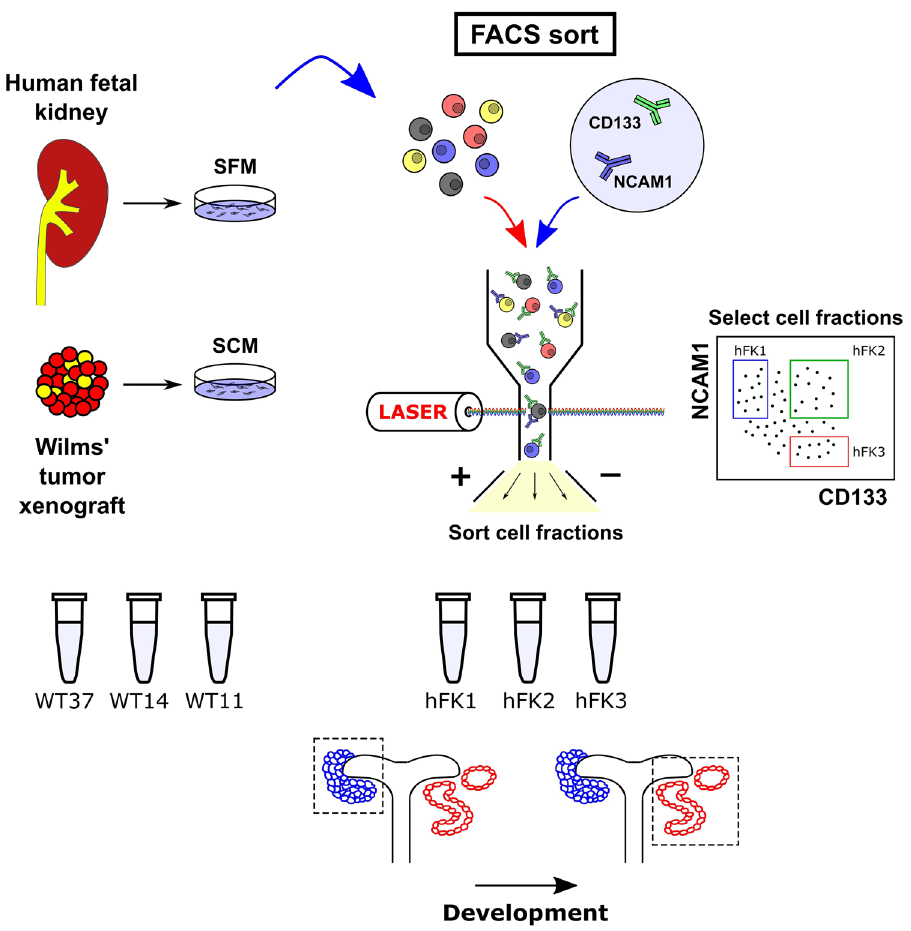
Figure 1. A sketch of the experiments performed to obtain the RNA samples that were analyzed in this study (see also Pode-Shakked et al. 7 ). Cells from a human fetal kidney (hFK) were cultured overnight in serum- free medium (SFM) which was found to help preserve a small population of undifferentiated cells. The cells were then dissociated and sorted by FACS to enrich for cell fractions representing three progressive renal developmental stages: NCAM-high/CD133-low (“hFK1”), a cell population that was previously found to be enriched for immature cells from early renal developmental stages, mainly the cap mesenchyme; NCAM- high/CD133-high (“hFK2”), an intermediate state, presumably enriched for cells representing early epithelial structures; and NCAM-low/CD133-high (“hFK3”), a population enriched for more differentiated epithelial cells. In parallel, cells from three blastemal-predominant Wilms’ tumor patient-derived xenografts (“WT11”, “WT14”, and “WT37”) were cultured overnight in serum-containing medium (SCM). RNA from all samples was extracted and deeply sequenced